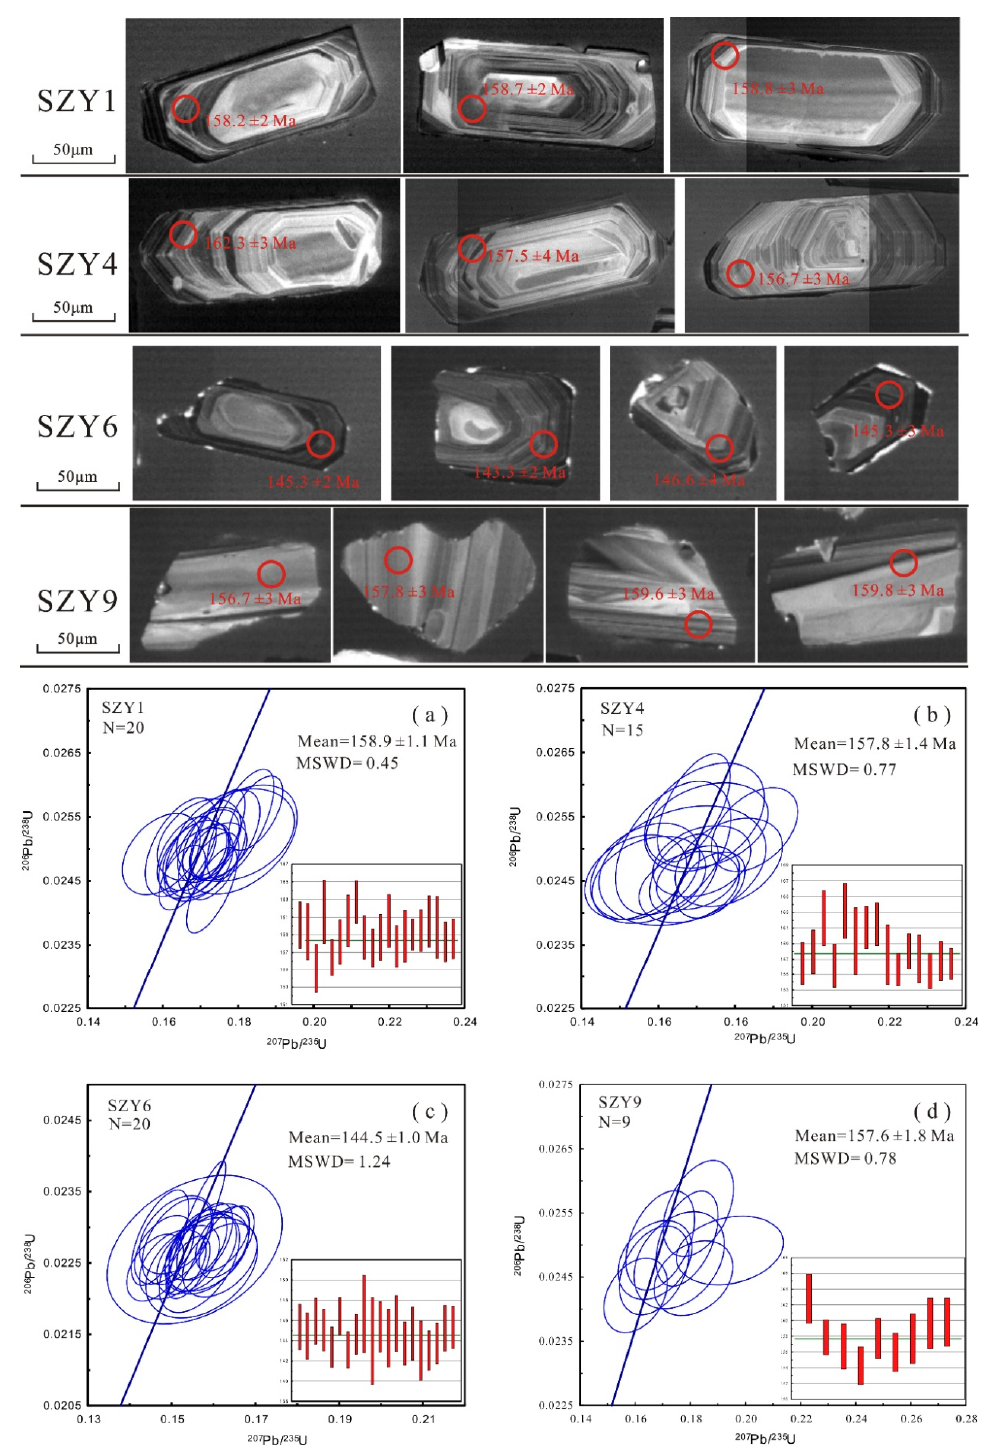
Figure 5. U–Pb concordia diagrams of zircon data and representative cathodoluminescence images of zircons from the Qianlishan complex: ( a ) main-phase porphyritic granites; ( b ) main-phase equigranular granites; ( c ) granite porphyry; and ( d ) mafic dykes. MSWD—mean square of weighted deviates.